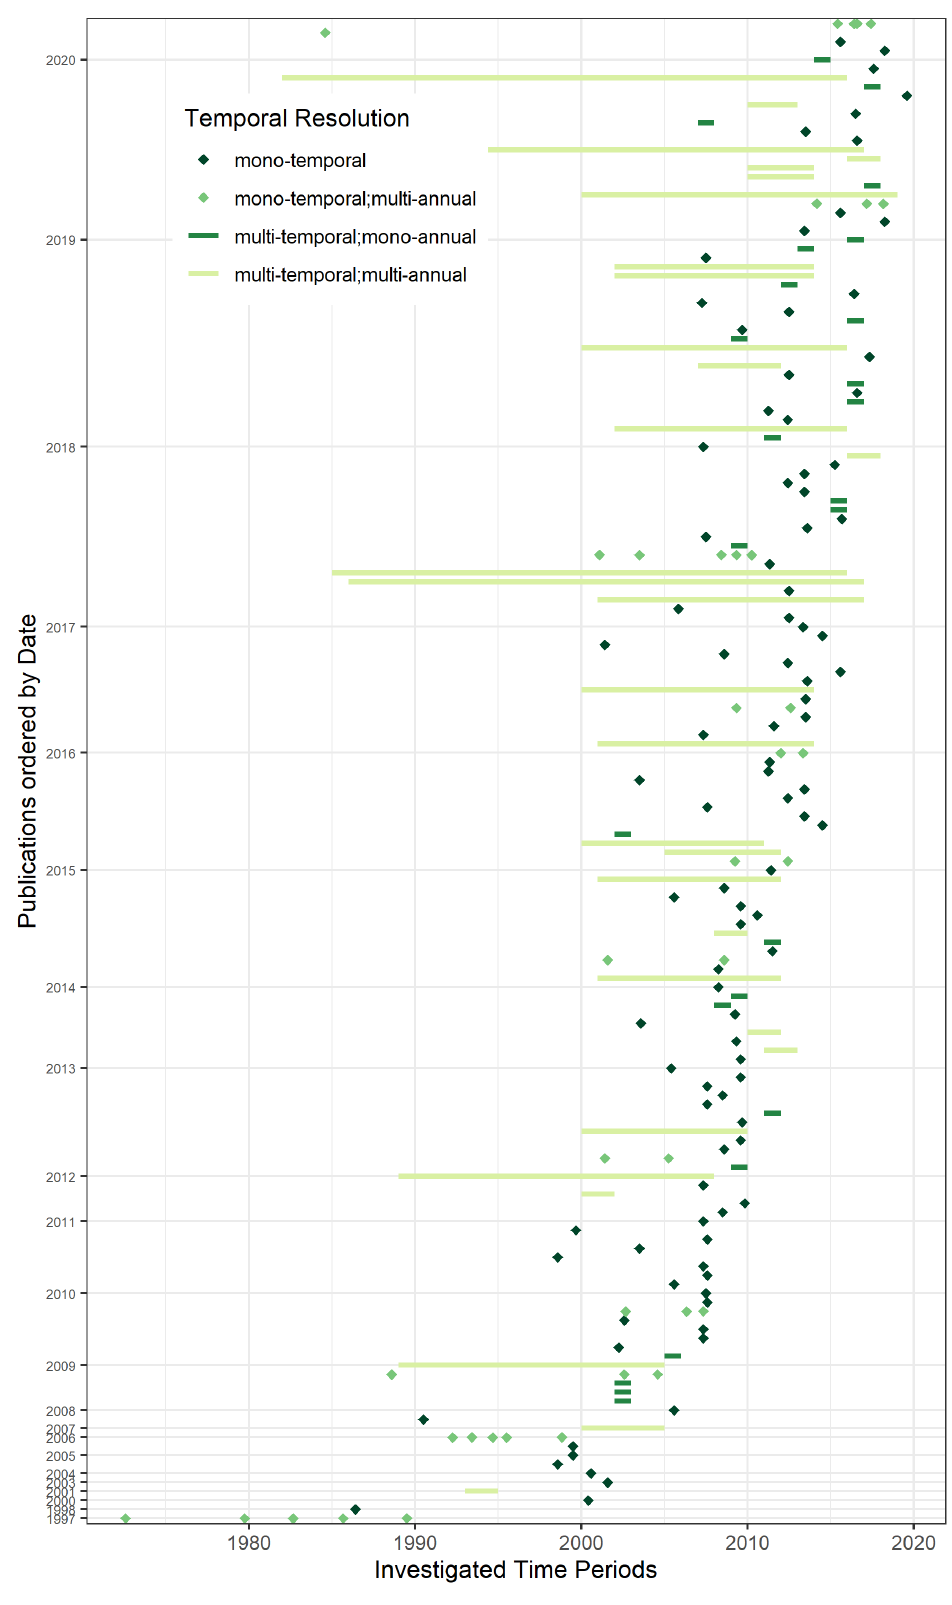
Figure 15. Investigated time periods (x-axis) for every publication (y-axis). The dates on the y-axis show publication years.